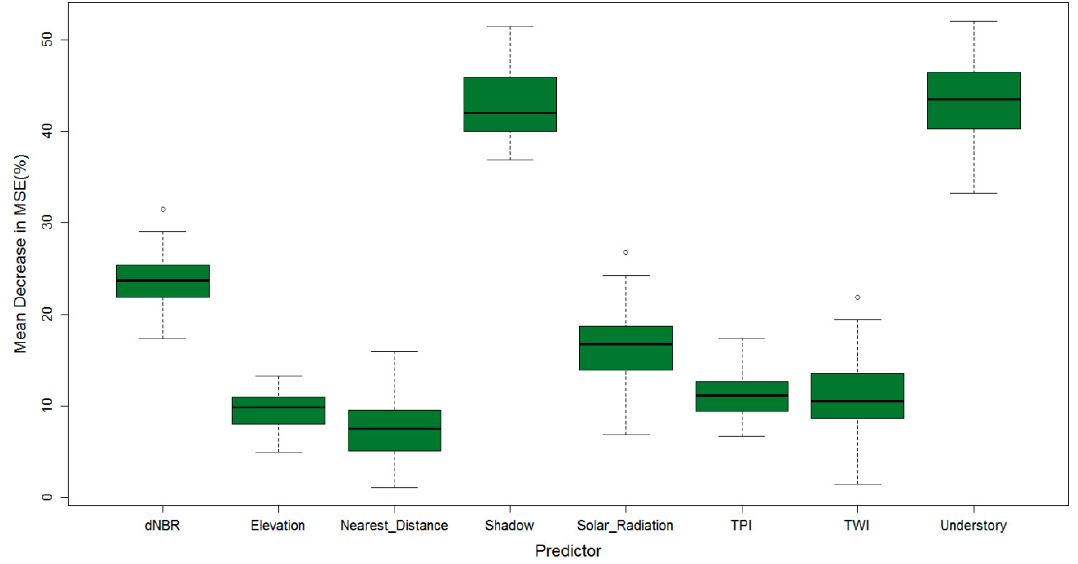
Figure 6. Relative importance from 50 random forest models, measured as the normalized difference between the mean square errors (MSE) when permuting the out-of-bag portion of the data and the MSE when permuting given variable. Magnitude of decrease of in MSE indicates relative importance of predictor variable (see Table 3 for variable abbreviations).